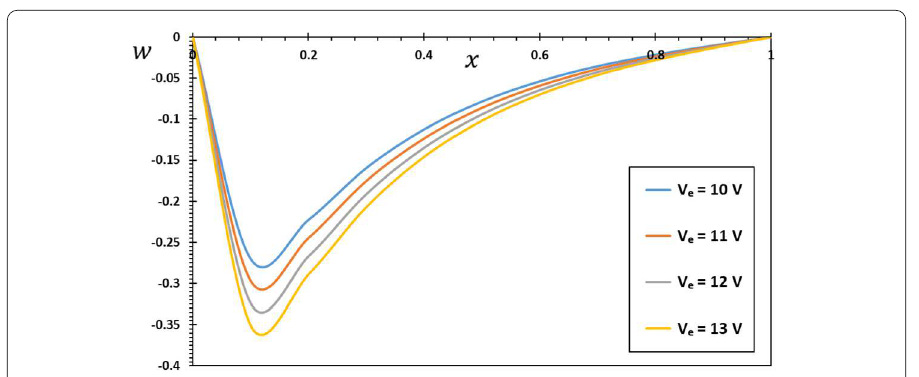
Figure 10 The effect of electric voltage V 2 e on the variation of the deflection